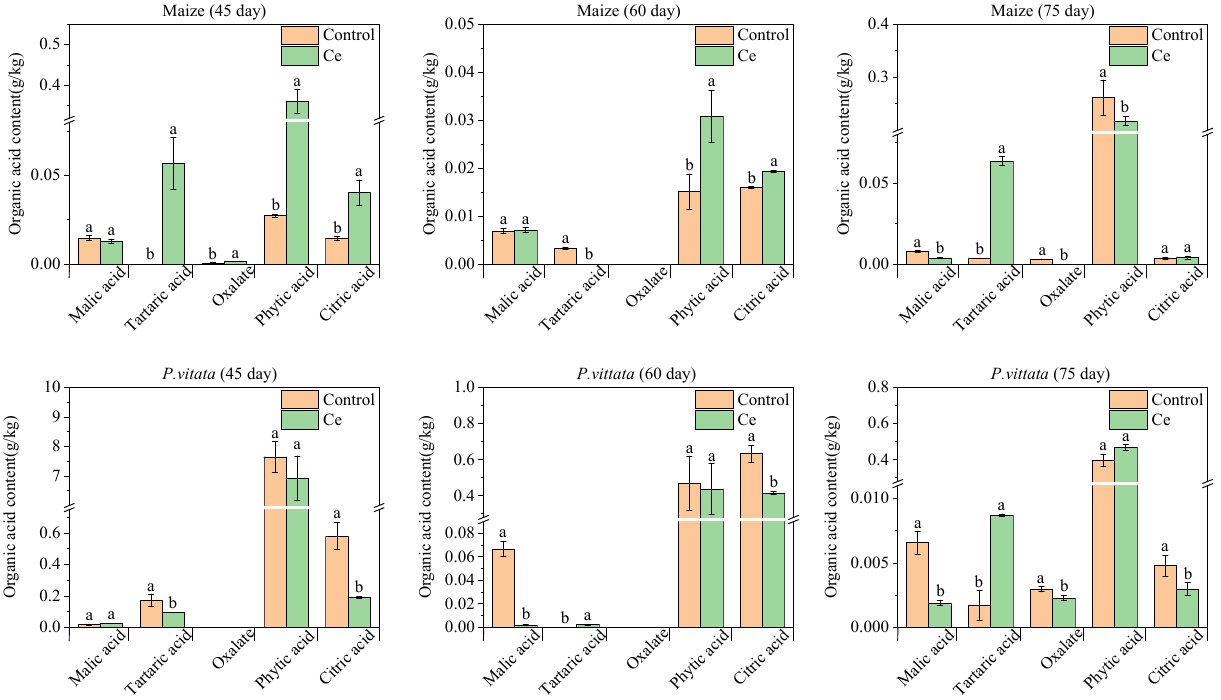
Figure 4. Effects of colonization by Ce on the types and content of organic acids secreted by maize and P. vittata under arsenic stress. Ce, Claroideoglomus etunicatum . Lowercase letters “a” and “b” in the same group in the graph indicate significant differences between treatments ( p < 0.05).